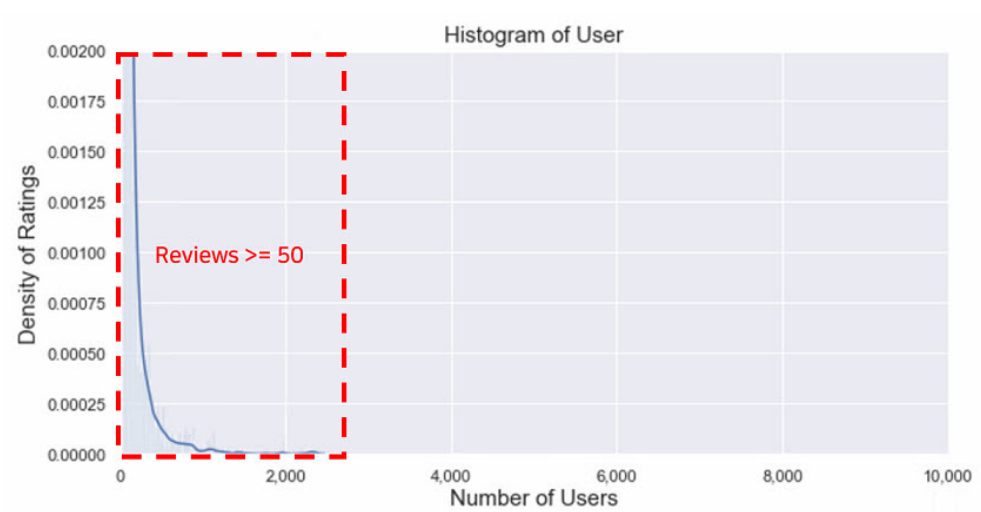
Figure 5. Long-tail graph in user dataset of